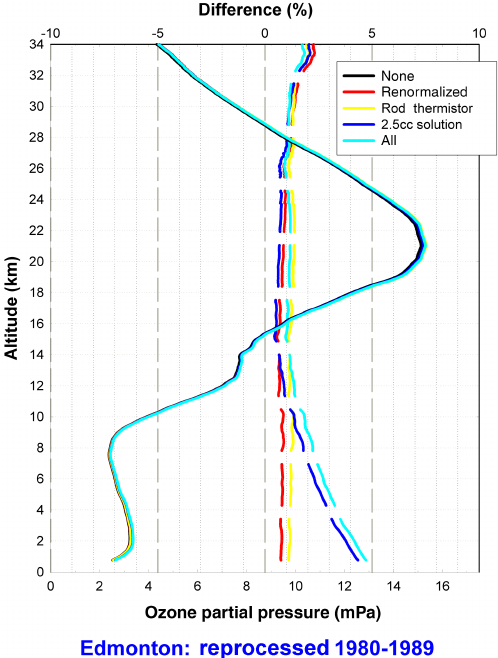
Figure 1. Average ozone profile at Edmonton before (“None”) and after corrections to the Brewer–Mast record. Dashed lines show dif- ferences from “None” in percent. “Renormalized” shows the aver- age change introduced by the use of the McPeters and Labow (2012) climatology (see Sect. 2.1); “Tarasick et al.” shows that from the re- sponse correction (Sect. 2.2); “Mateer” shows the change caused by the switch to WMO-recommended pump corrections (Sect. 2.3). Note that in each case the profile is normalized, so that the curves Tarasick et al. and Mateer both include the effects of renormaliza- tion. The largest change is in the lowermost troposphere, where the response correction (Tarasick et al.) raises ozone values by about 15%.